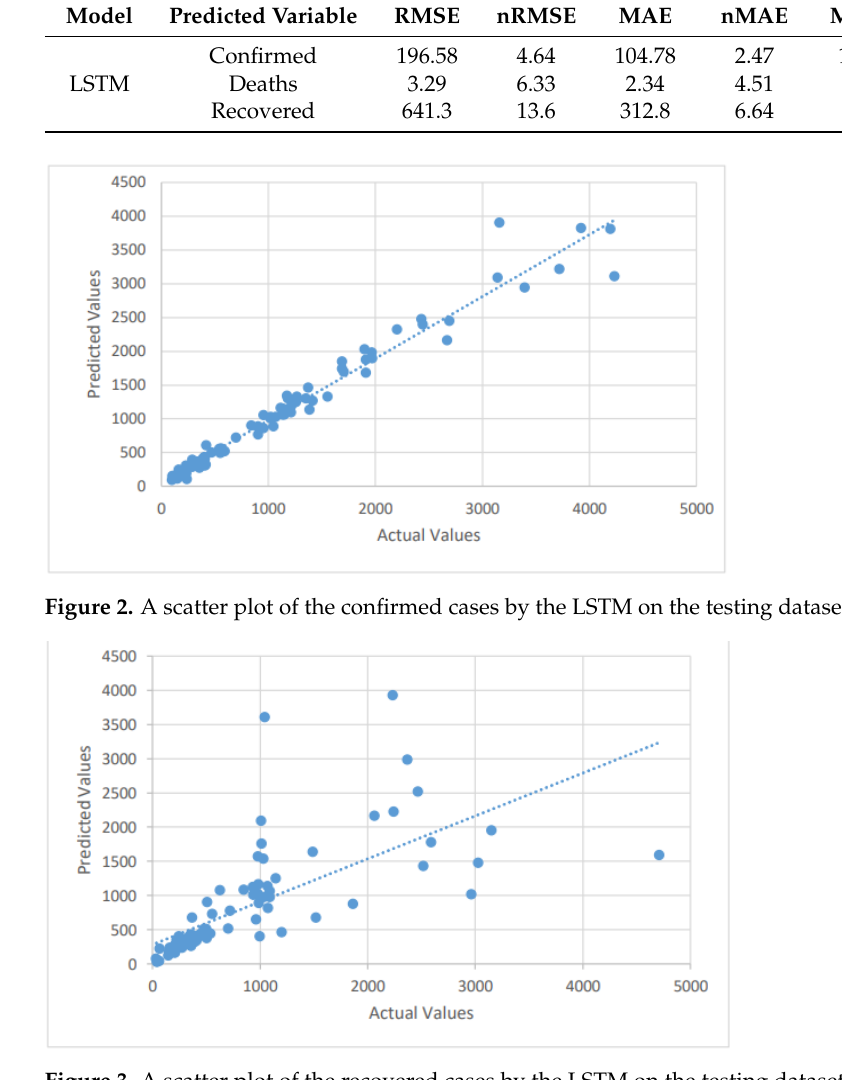
Figure 3. A scatter plot of the recovered cases by the LSTM on the testing